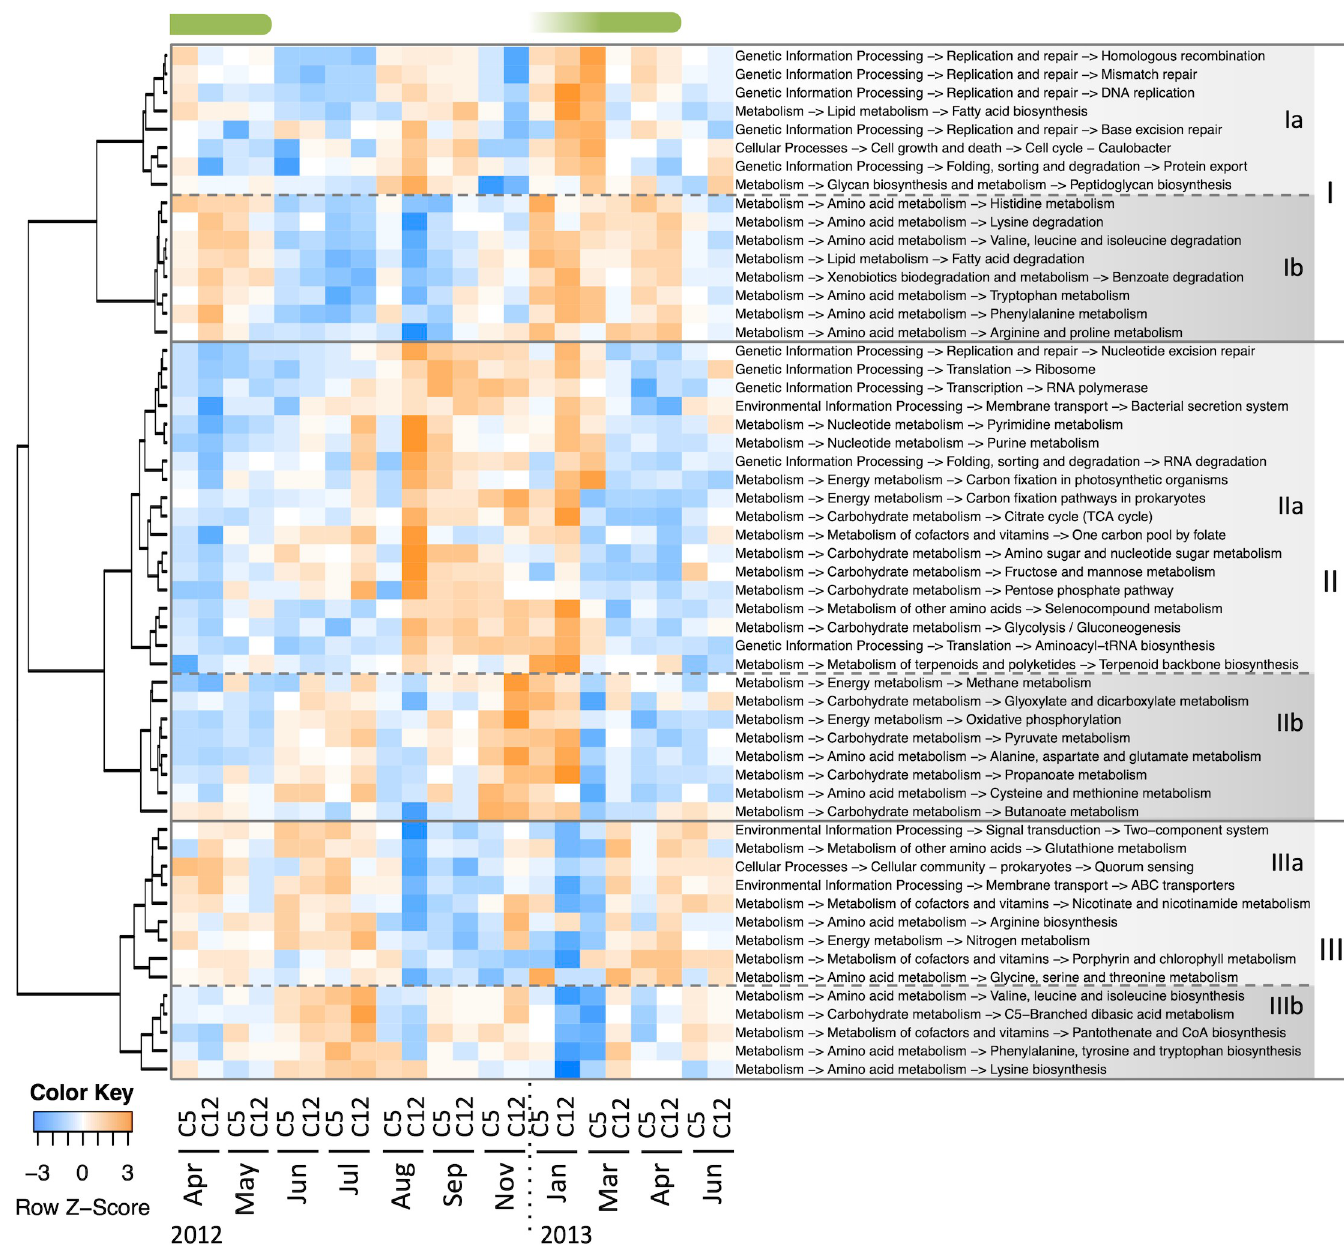
Fig 5. Seasonal patterns of KEGG pathways in non-cyanobacterial prokaryotic sequences. The labels indicate “broad category ! KEGG category ! KEGG pathway”. Only KEGG pathways with max abundance > 0.01 are shown. The green bars above the heatmap indicate spring phytoplankton blooms.